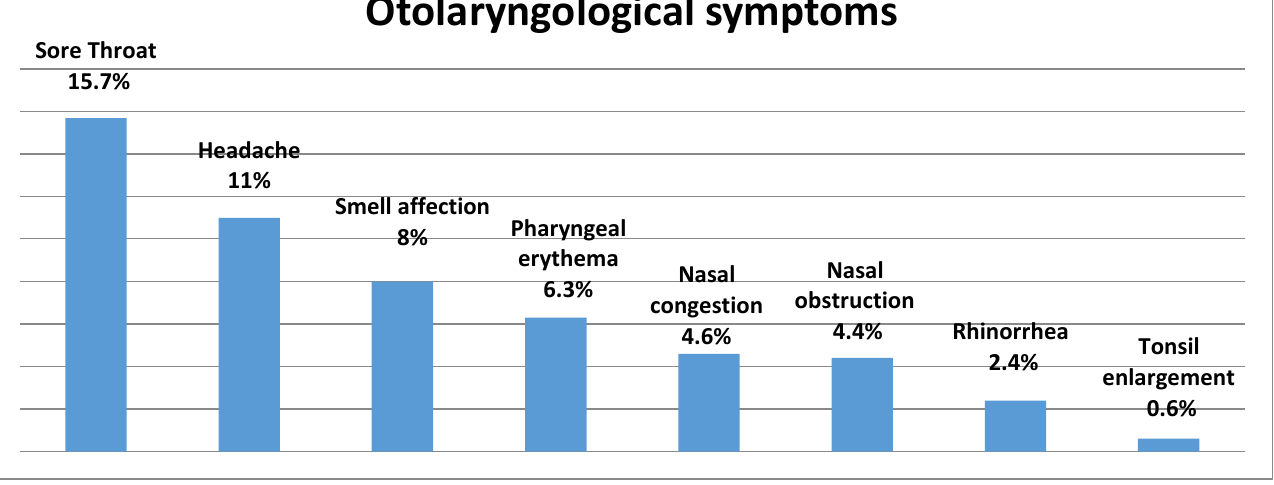
Figure 1: Different otolaryngological manifestation in COVID-19 patients.